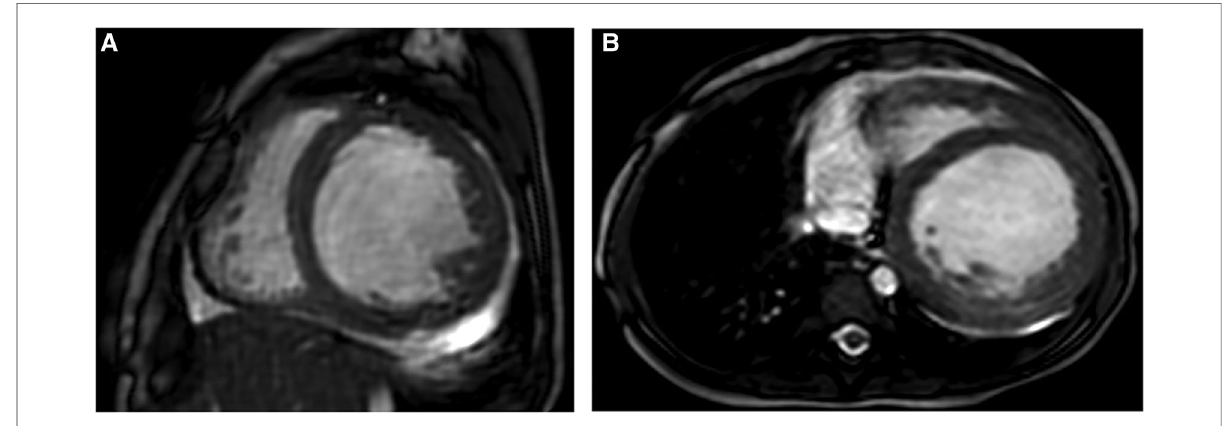
FIGURE 1 Representative MRI scans of a 1-year-old female patient with EFE who presented with severe heart failure and had PCR once due to the heart event. ( A,B ) Short-axis and axial FIESTA cine showing thickened endocardium with obviously increased and hypertrophied myocardial trabeculae. EFE, endocardial fi